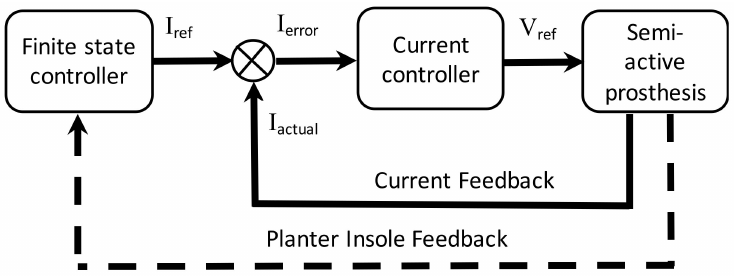
Figure 5. Block diagram of the control